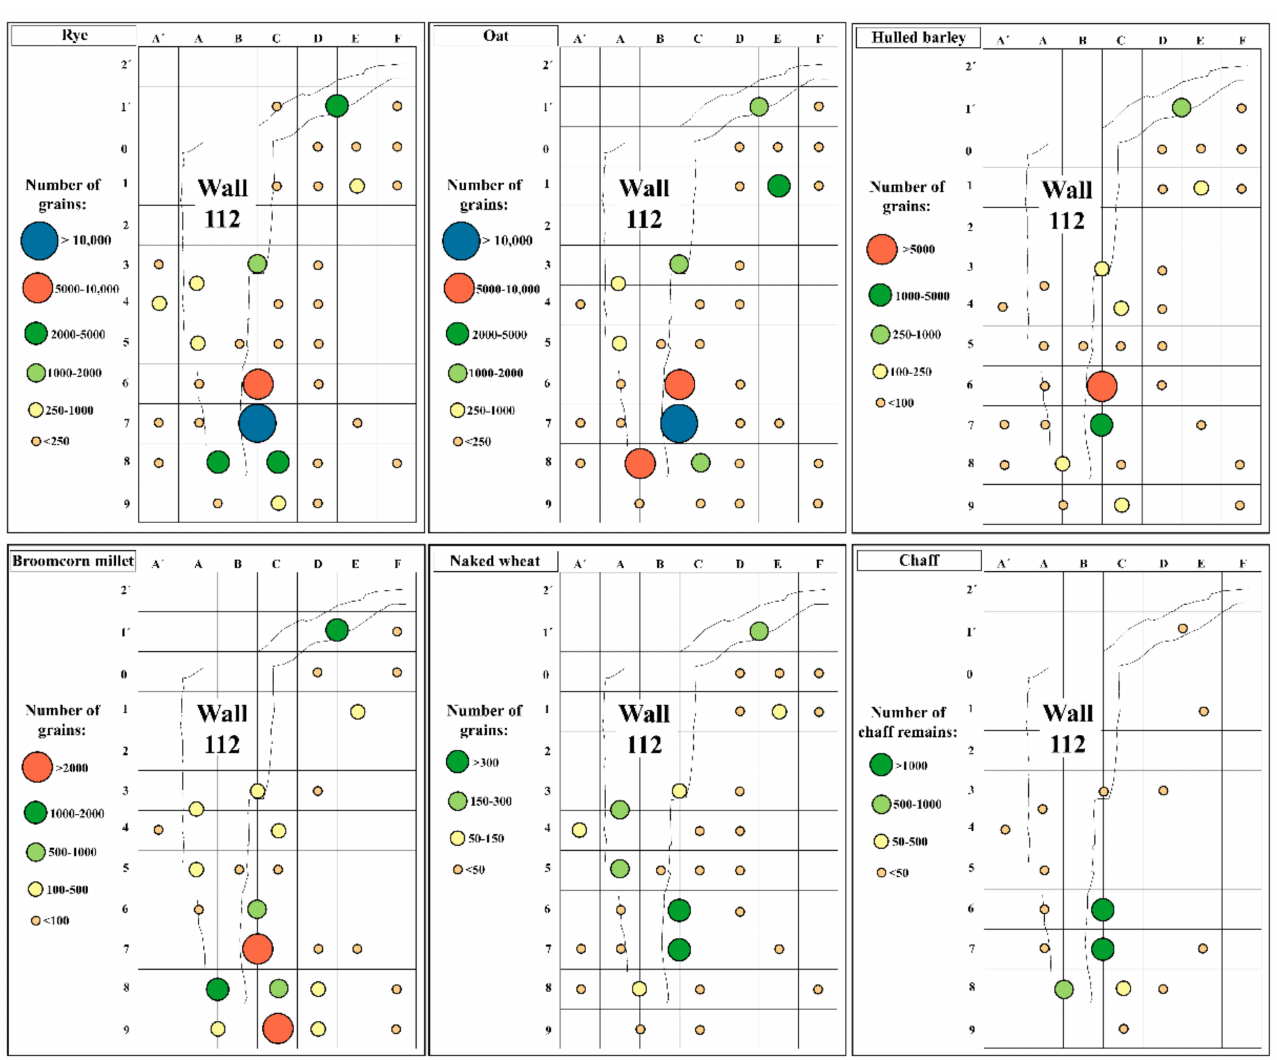
Figure 4. Individual results of the main cereal grains and chaff per square in Sector 1 (total results); only units. Foxtail millet grains were scarce, and for that reason are not graphically represented. Results from the first moment as well from row G onwards revealed few remains and for that reason are not